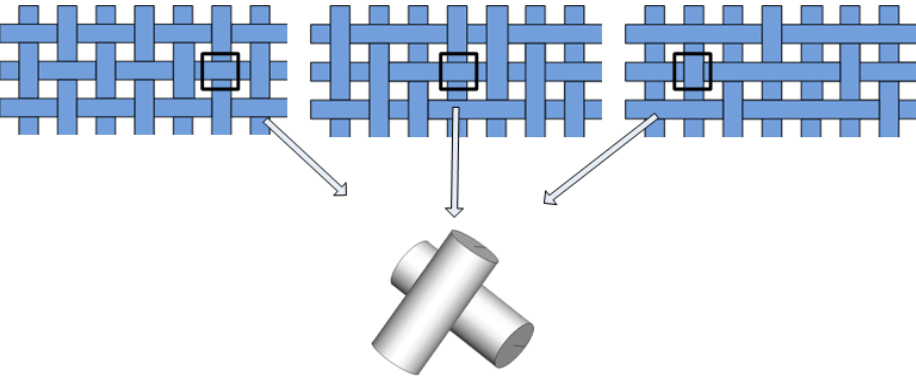
Figure 1. Weaving patterns of filter cloth (plain weave, twill weave, and satin weave).